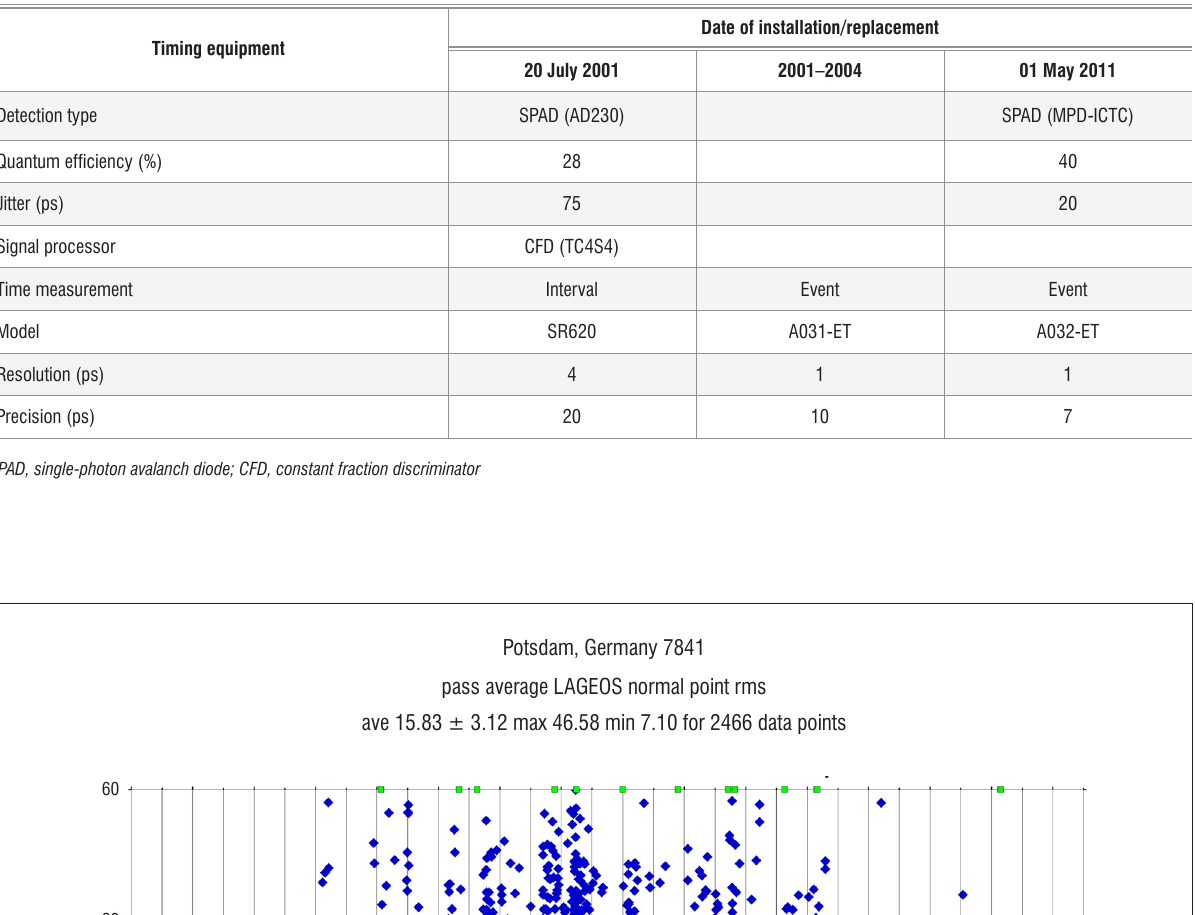
Table 1 : Historical improvement of the Potsdam satellite laser ranging station timing system 45